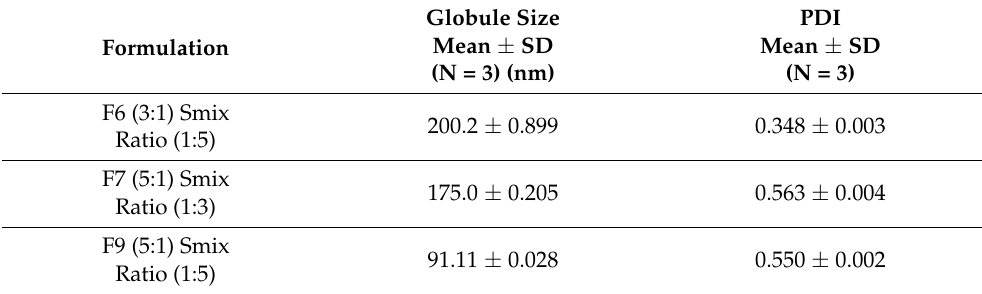
Table 5. Comparative analysis of the globule size and PDI for different formulations.